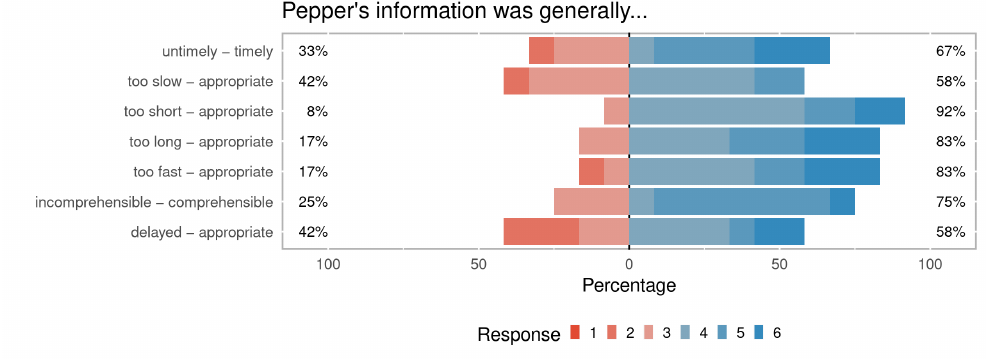
Figure 9. Intelligibility of Pepper’s